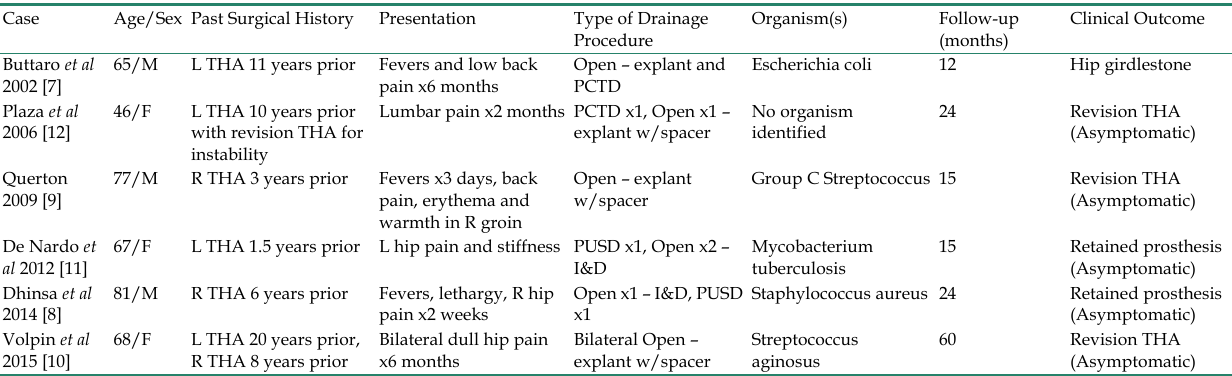
Table 2. Literature review: data and outcomes.